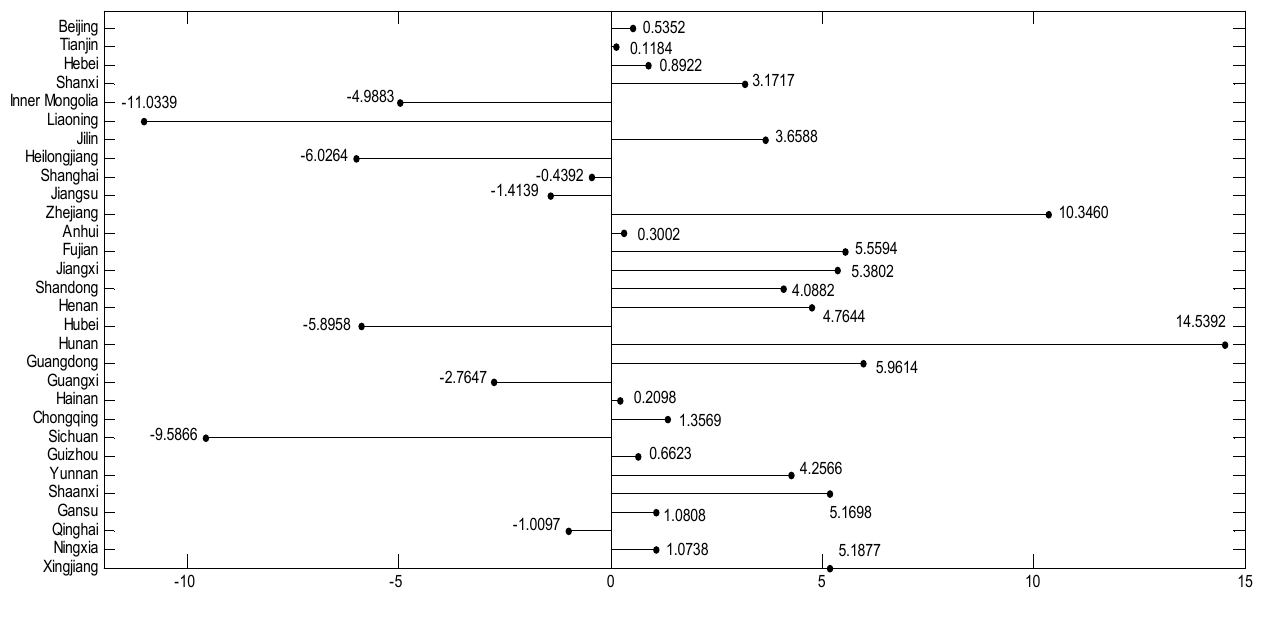
Figure 5. The contribution value of carbon